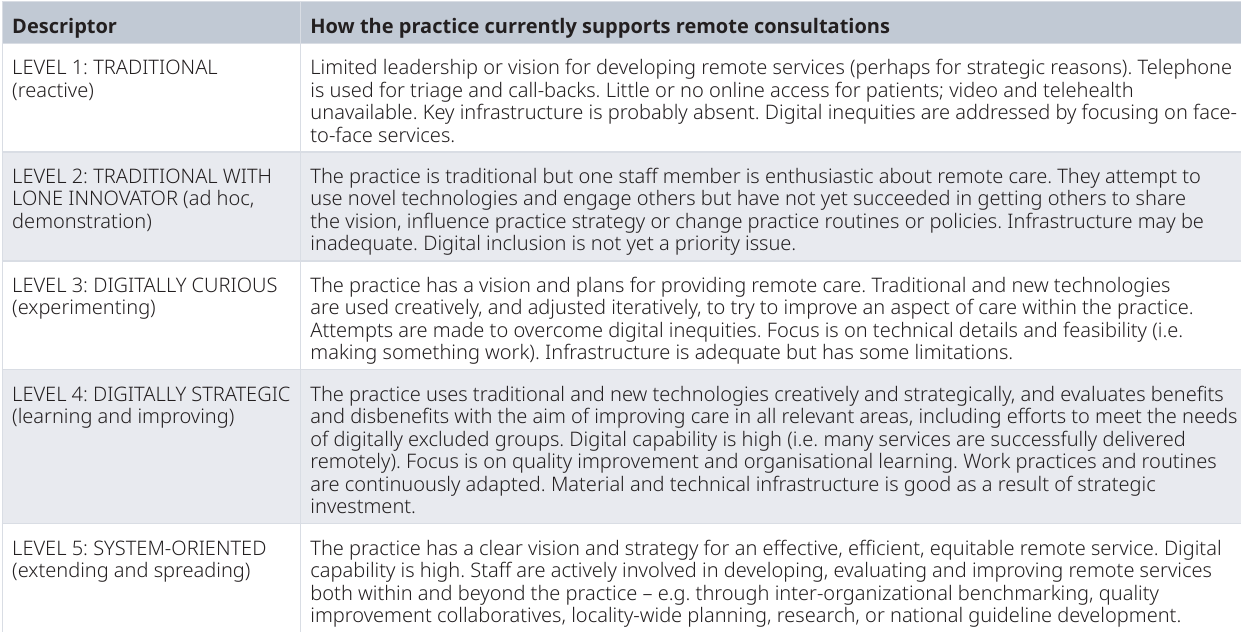
Table 2. Digital maturity scale for general practices. Adapted from Greenhalgh et al. 9